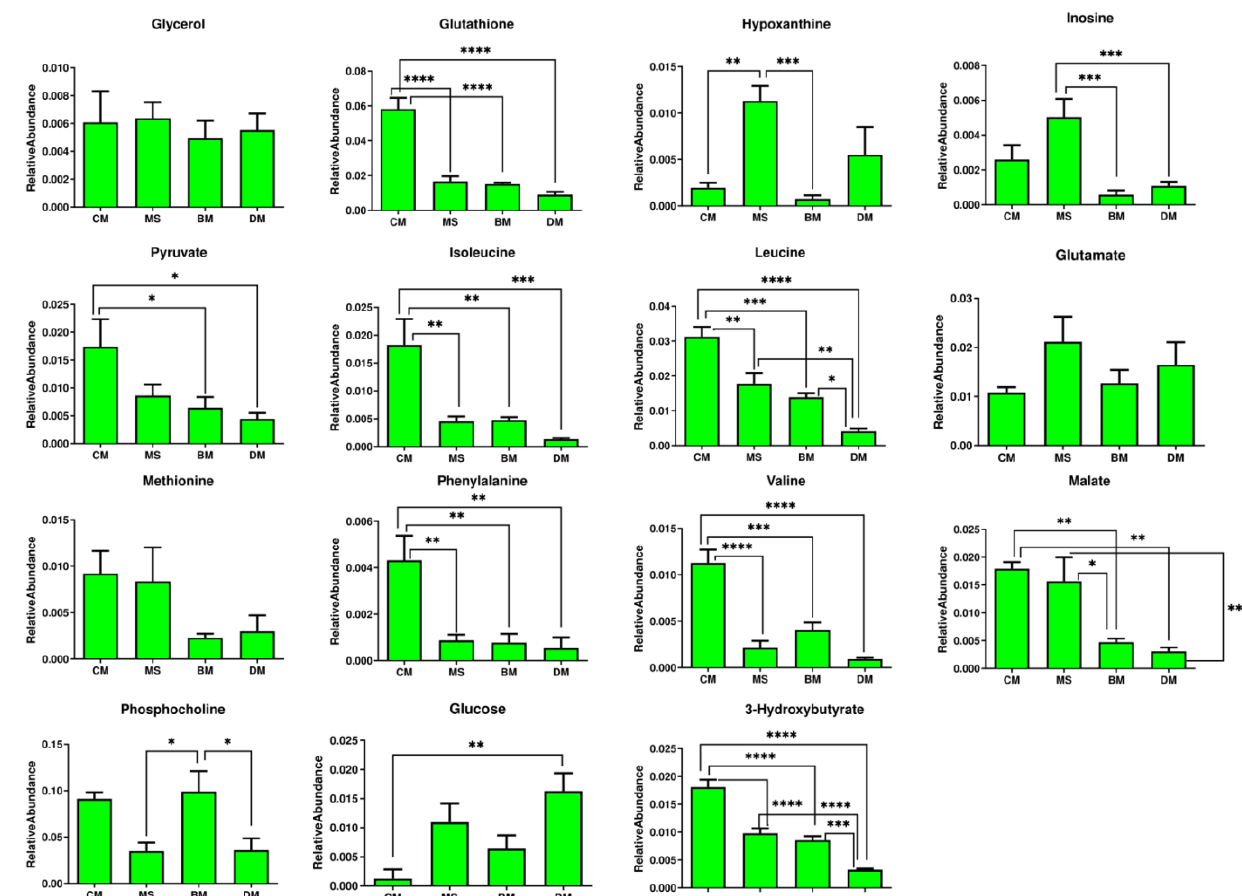
Figure 5. Relative quantification of the major differentiating metabolites based on the mean peak area of the related signals. CM = Chicken; MS = Chevon; BM = Beef; DM = Donkey. * depicts the differences between meat groups. Statistical differences of metabolites between groups were calculated by using one-way analysis of variance and a Tukey multiple comparison test. Statistical icons: * p < 0.05, ** p < 0.01, *** p < 0.001, and **** p < 0.0001.